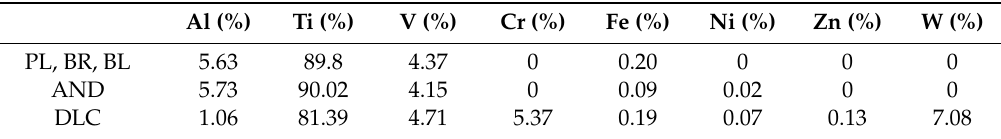
Table 2. The relative elemental composition in the surface layer of Ti6Al4V, grade 5 ELI, modified by polishing (PL), by DLC-coating (DLC), by brushing (BR), by anodizing (AND), or by blasting (BL), calculated from ED-XRF.